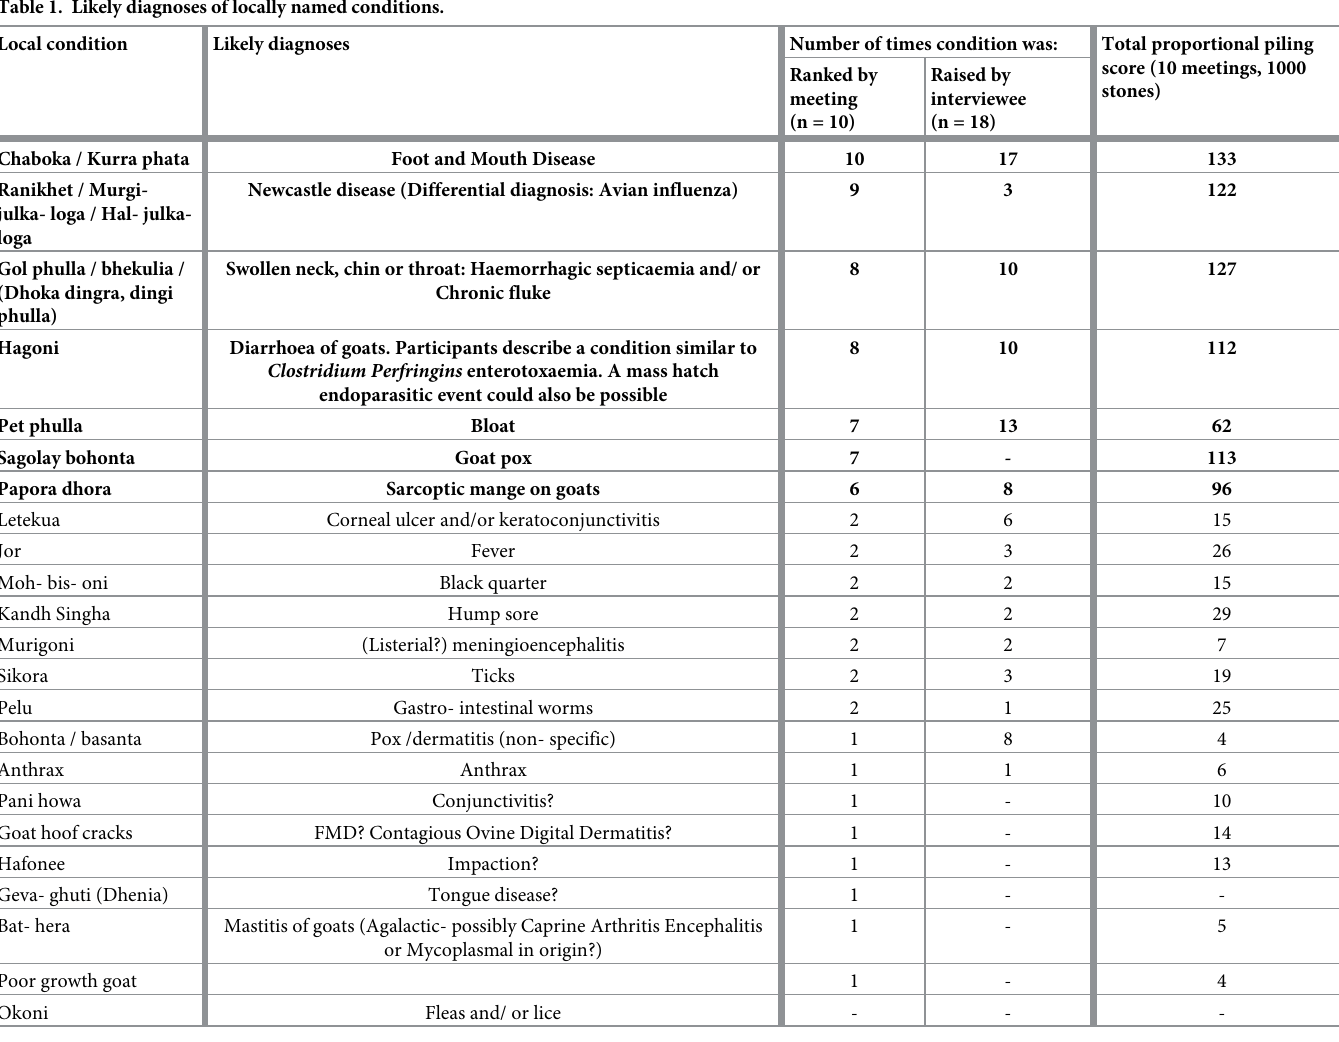
Table 1. Likely diagnoses of locally named